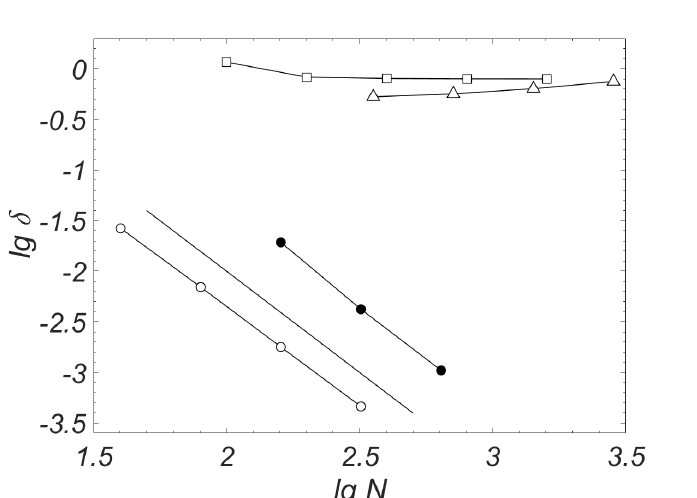
Figure 5. Fabry–Perot interferometer. The error of calculating the spectrum in the Hausdorff metric (40), depending on the number of steps along the ray coordinate. Line without markers is straight with slope − 2. Empty markers stand for s-polarization, filled ones are p-polarization. ◦ is bicompact scheme, (cid:3) is finite element method, (cid:52) is finite-difference time domain